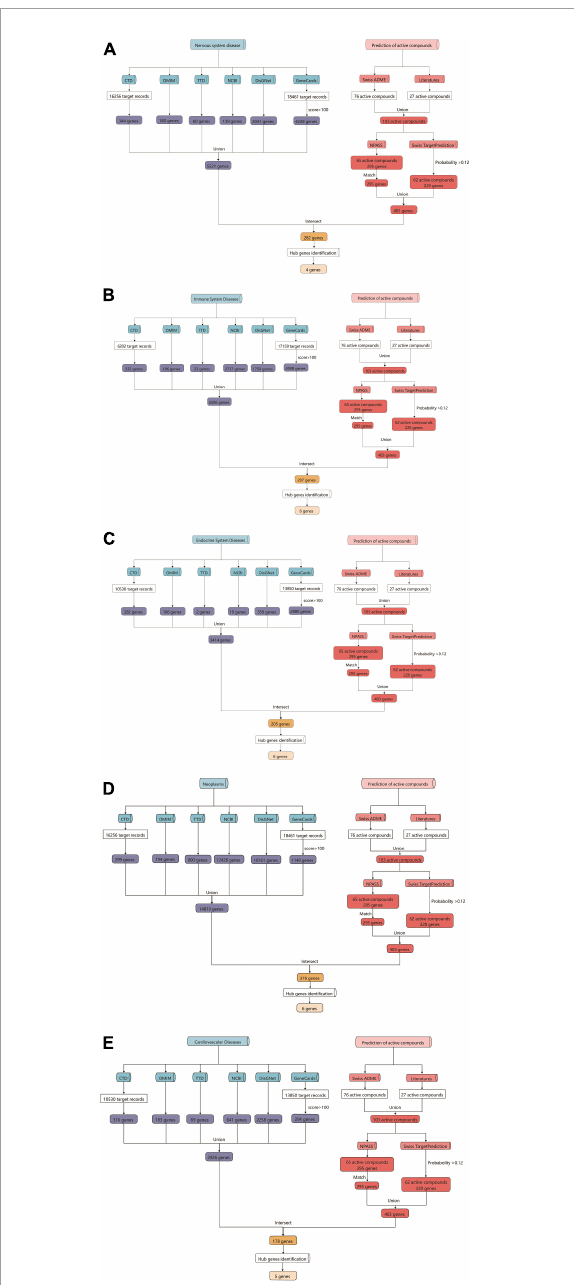
FIGURE2 Flow chart of the prediction for targets of active components from Tremella aurantialba by network pharmacological analysis. (A) Tremella aurantialba- nervous system diseases; (B) Tremella aurantialba- immune system diseases; (C) Tremella aurantialba- endocrine system diseases; (D) Tremella aurantialba- neoplasm system diseases; (E) Tremella aurantialba- cardiovascular system